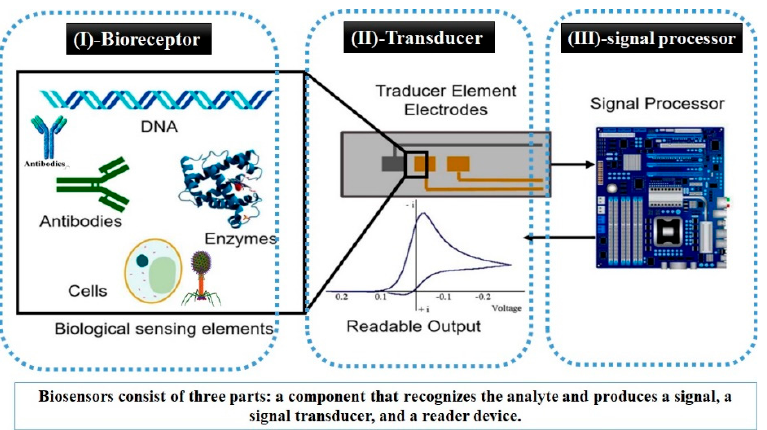
bio-receptor, ( II ) a transducer, and ( III ) signal processor